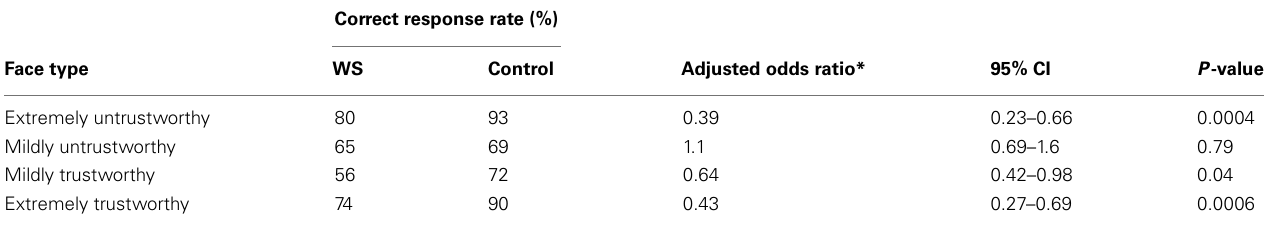
Table 2 | Correct response rates and adjusted odds ratios comparingWS participants to control